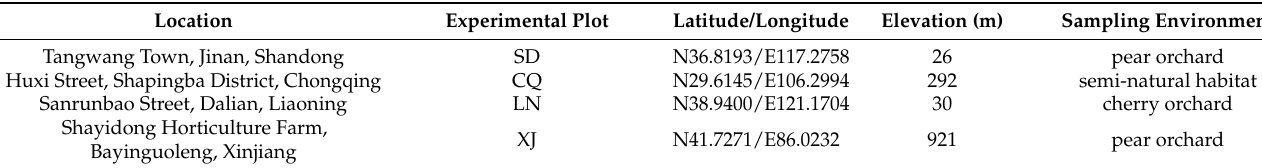
Table 1. O. excavata nest tube collection sample